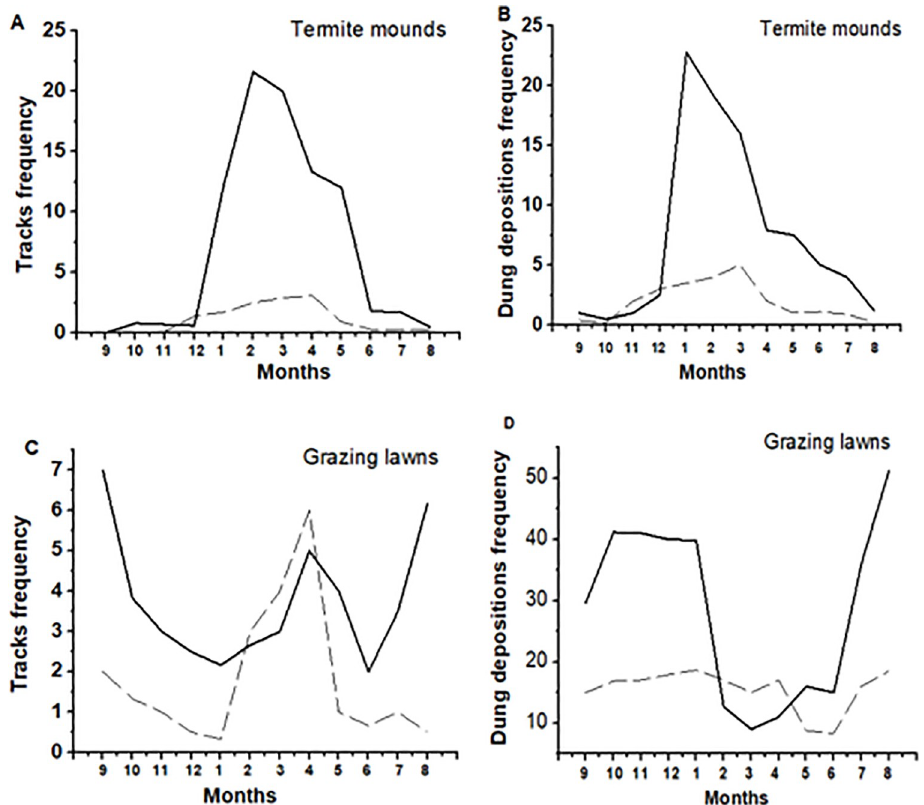
Fig 7. Herbivore presence using tracks (A) and dung (B) on termite mounds (solid lines) vs controls (dashed lines) and tracks (C) and dung (D) between grazing lawns (solid lines) vs controls (dashed lines) over the year.